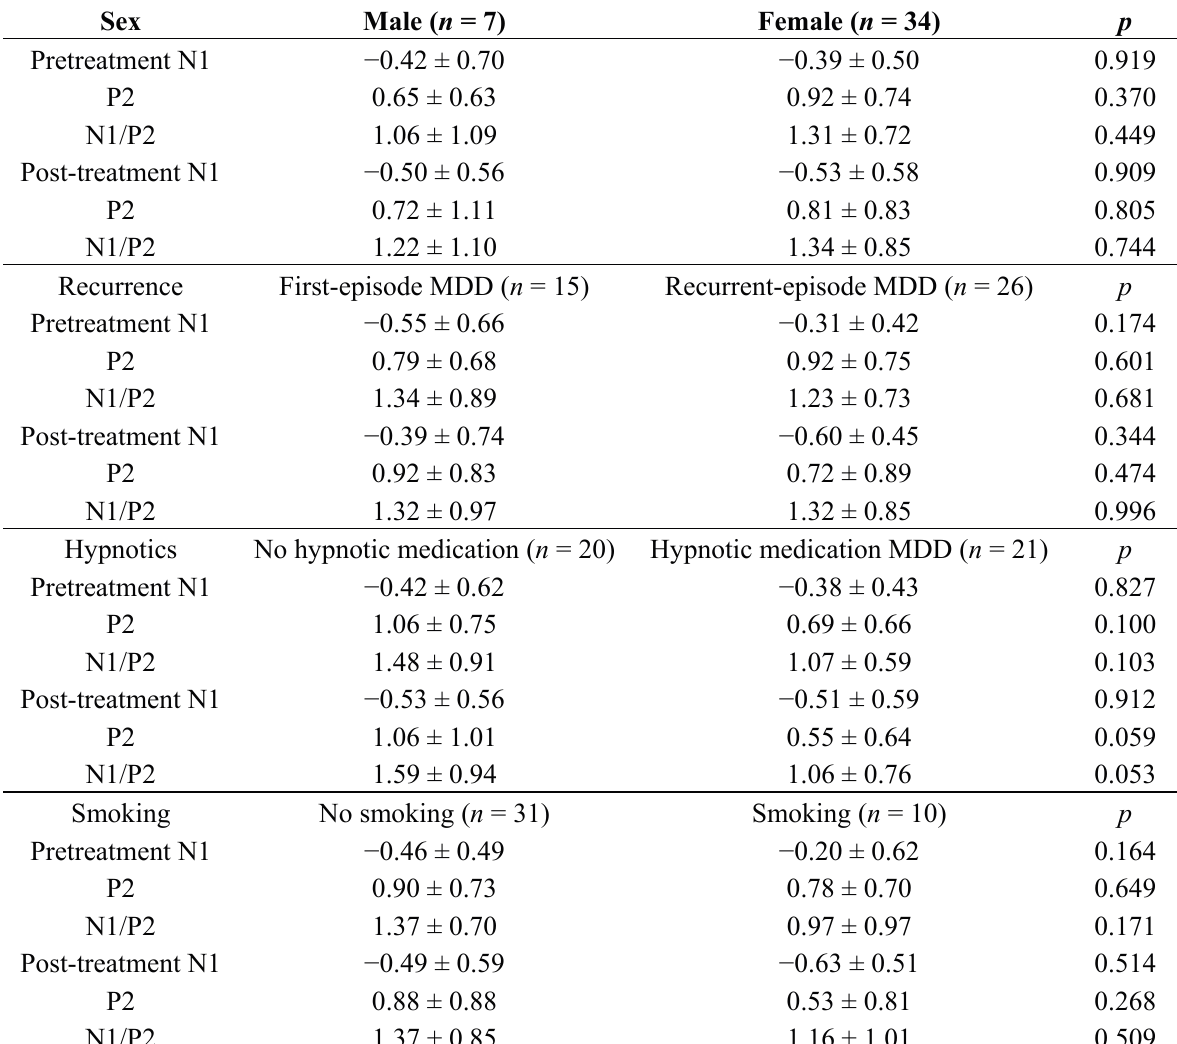
Table 1. Comparison of pretreatment and post-treatment loudness dependence of auditory evoked potentials (LDAEP) between groups according to sex, the number of episodes, hypnotic medication, and smoking.